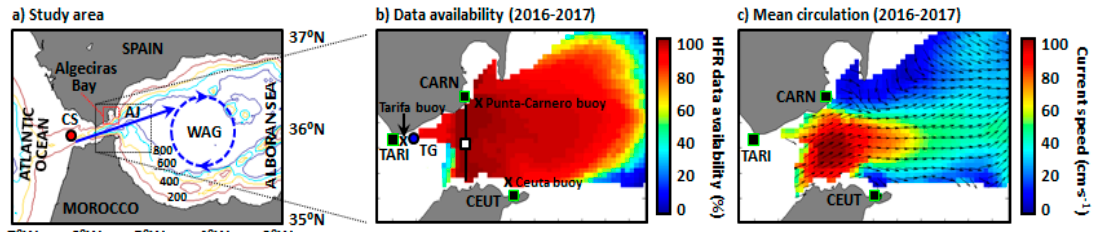
Figure 1. ( a ) Study area: surface Atlantic Jet (AJ) flowing through the Strait of Gibraltar into the Alboran Sea, feeding the Western Alboran Gyre (WAG); isobath depths are labeled every 200 m. Red dot indicates a topographic feature: Camarinal Sill (CS). ( b ) HFR hourly data availability for the period 2016–2017: solid black squares represent radar sites, black crosses indicate buoys locations, blue dot denotes Tarifa tide-gauge (TG) situation. Black line and the related white square indicate the selected transect and its midpoint, respectively; ( c ) HFR-derived mean surface circulation pattern for 2016–2017. The position, intensity and direction of the AJ fluctuate in a broad range of temporal scales,